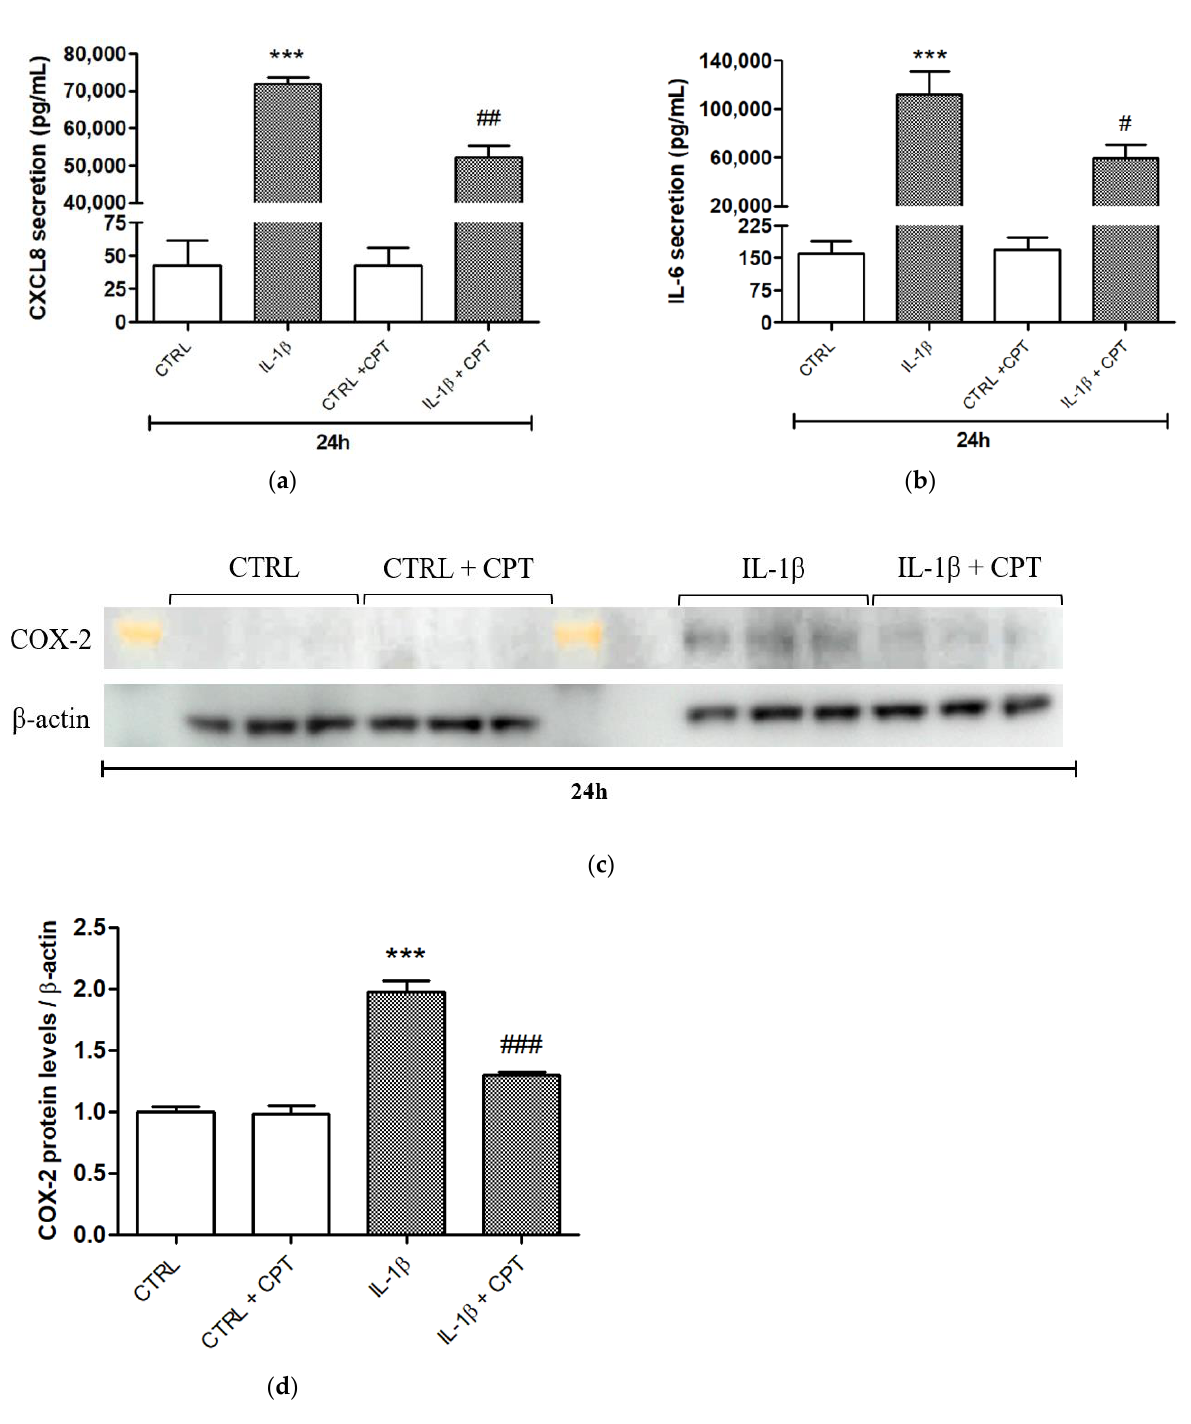
Figure 5. CPT-11 reduces IL- 1β -induced pro- inflammatory mediators’ expression at the protein level, in HSF. ( a ) CXCL8 and ( b ) IL-6 secretion from HSF treated with IL- 1β and co -treated with CPT-11, for 24 h, were evaluated by ELISA in cell supernatants. ( c ) COX-2 intracellular protein levels were measured by Western blot (n = 3). The yellow mark indicates a molecular weight of 76 kDa (from Amersham ECL Full-Range Rainbow Molecular Weight Markers, reference RPN800E). ( d ) Signal intensities from Western blot were quantified (arbitrary units). Quantitative results are expressed as mean ± SEM. Statistical significance is indicated as follows: p -value < 0.001 (***) compared to control at the corresponding time of treatment; p -value < 0.05 (#), p -value < 0.01 (##), p -value < 0.001 (###) compared to the corresponding treatment without CPT-11.